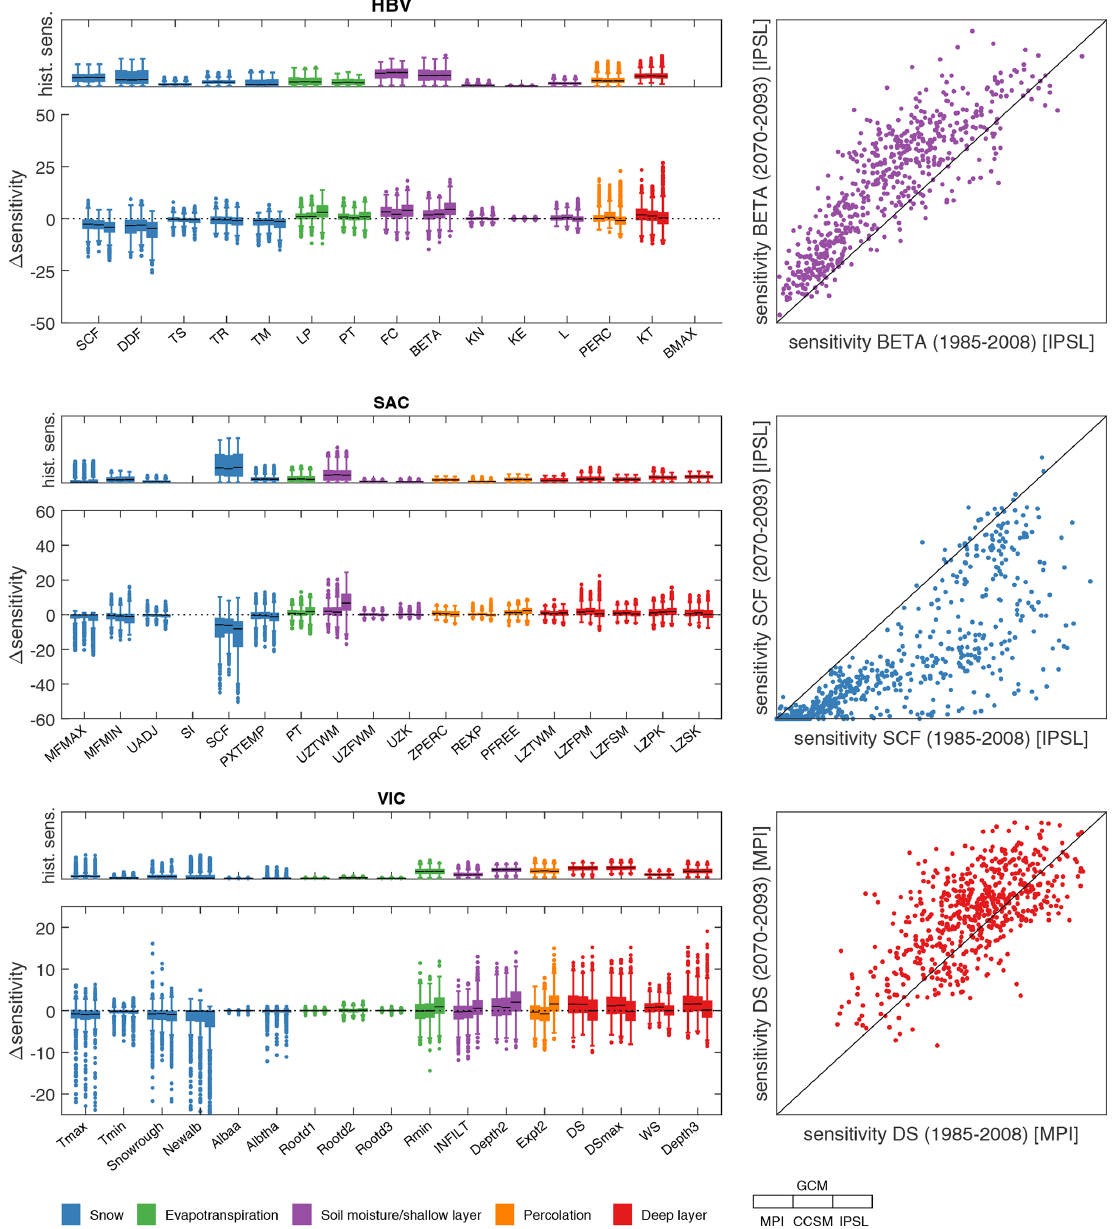
Figure C1. The distribution of change in parameter sensitivity ( (cid:49) sensitivity) over 605 basins for the period 2070–2093 compared to 1985– 2008, displayed per parameter per model, for three different GCM forcings for the discharge timing. Above each (cid:49) sensitivity panel, historical sensitivity is displayed. The panels on the right show the data for a selected case per